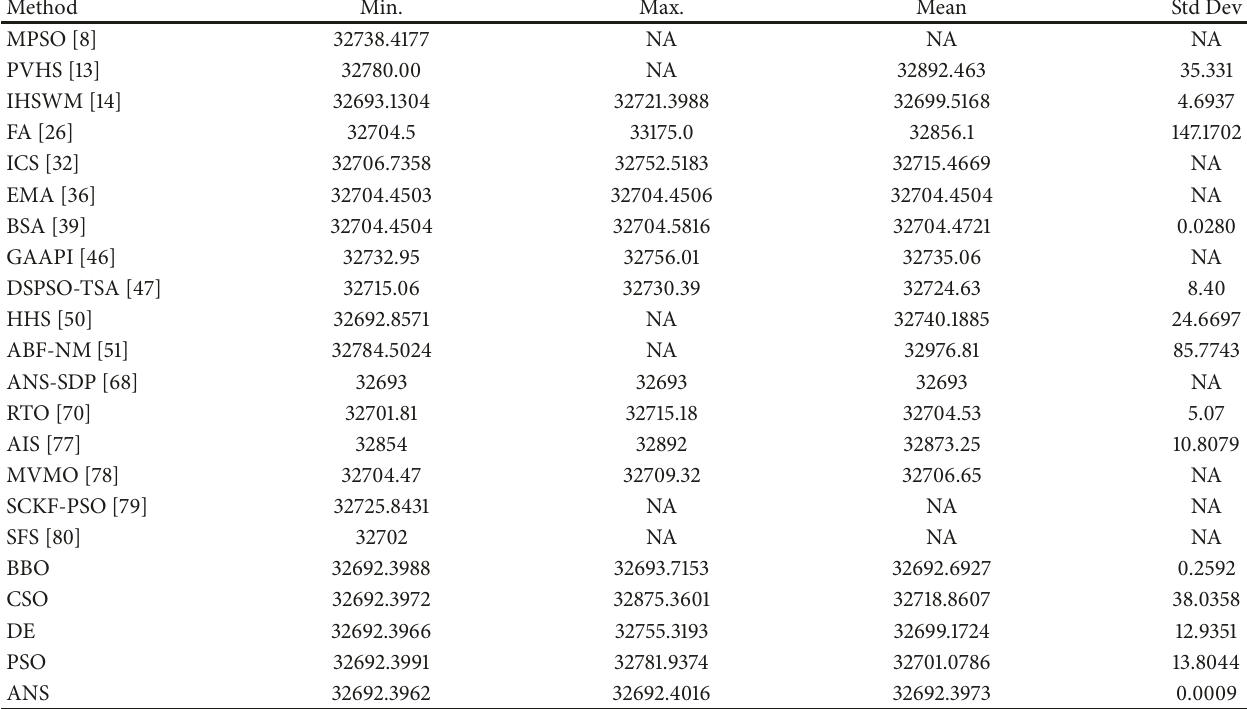
Table 3: Comparison of simulation results ($/h) for 15-generator system (Case II).